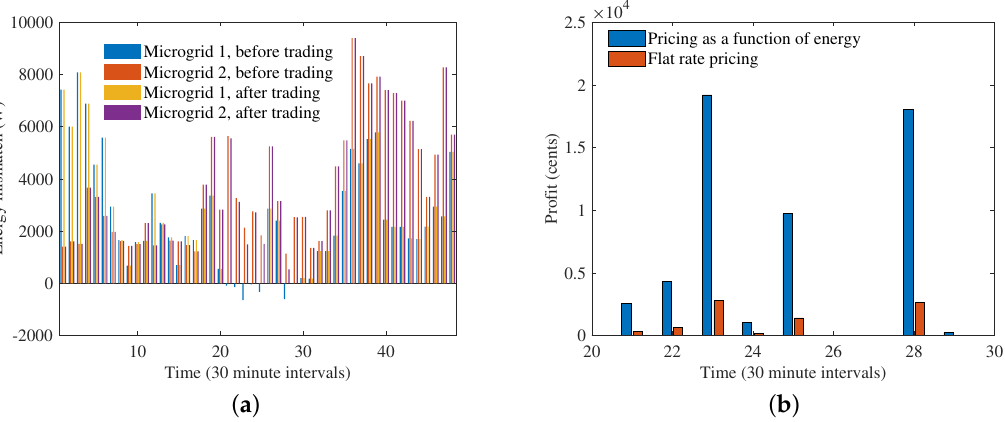
Figure 9. Energy mismatch before and after inter-microgrid energy trading at the two microgrids and hourly profit. ( a ) Energy mismatch; ( b )